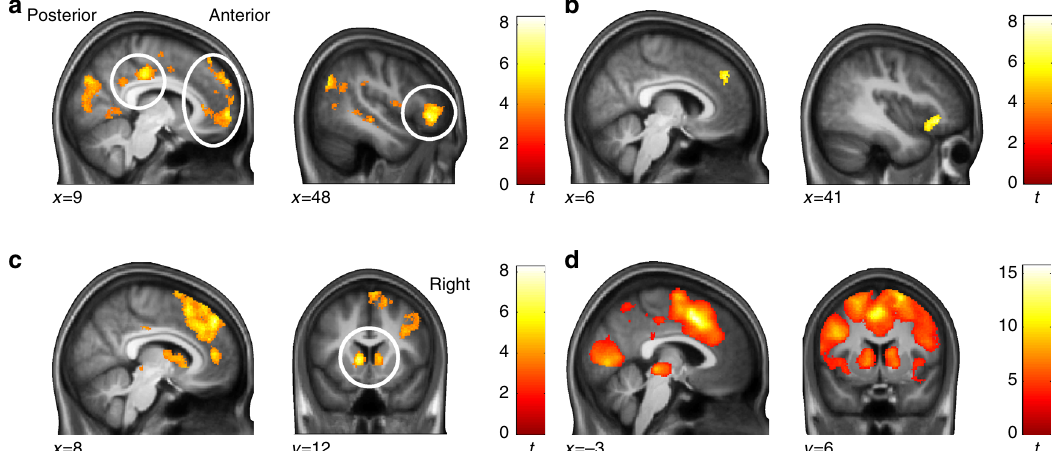
Fig. 7 BOLD signals related to choice uncertainties, discrepancies, and RTs during the choice phase. a Choice uncertainty of the heuristic (i.e., probability of foraging success) showed a negative relation with BOLD signals in VMPFC (peak voxel: x ; y ; z (MNI) = 9; 59; − 2; t = 6.24), DMPFC ( x ; y ; z (MNI) = 3; 56; 33; t = 4.50), IFG ( x ; y ; z (MNI) = 48; 35; − 5; t = 7.37), and the posterior cingulate cortex ( x ; y ; z (MNI) = 15; − 27; 39; t = 7.63), among other regions. b Choice uncertainty of the optimal policy exhibited a negative correlation with DMPFC/ACC ( x ; y ; z (MNI) = 6; 42; 38; t = 4.81) and IFG ( x ; y ; z (MNI) = 48; 26; − 9; t = 5.88). c Discrepancies between the two policies showed a positive relation with DMPFC (extending into pre-SMA and ACC; x ; y ; z (MNI) = − 9; 36; 38; t = 8.25), bilateral dorsal striatum (left: x ; y ; z (MNI) = − 11; 12; 3; t = 7.16; right: x ; y ; z (MNI) = 11; 20; − 3; t = 7.66), and bilateral IFG (left: x ; y ; z (MNI) = − 30; 26; − 5; t = 6.17; right: x ; y ; z (MNI) = 50; 26; − 11; t = 6.85). d For completeness, (positive) correlations with log-transformed RTs are depicted. Overlay on group average T1-weighted image in MNI space; clusters are whole-brain FWE corrected for multiple comparisons at p < 0.05 with a cluster-de fi ning threshold of p < 0.001. Color bars depict t -values. See Supplementary Table 7 for a list of all clusters (as well as Supplementary Tables 8 – 10; Supplementary Fig. 14; and Supplementary Fig. 15 for further analyses of the choice phase). See Supplementary Table 11 and Supplementary Fig. 16 for BOLD signals during the